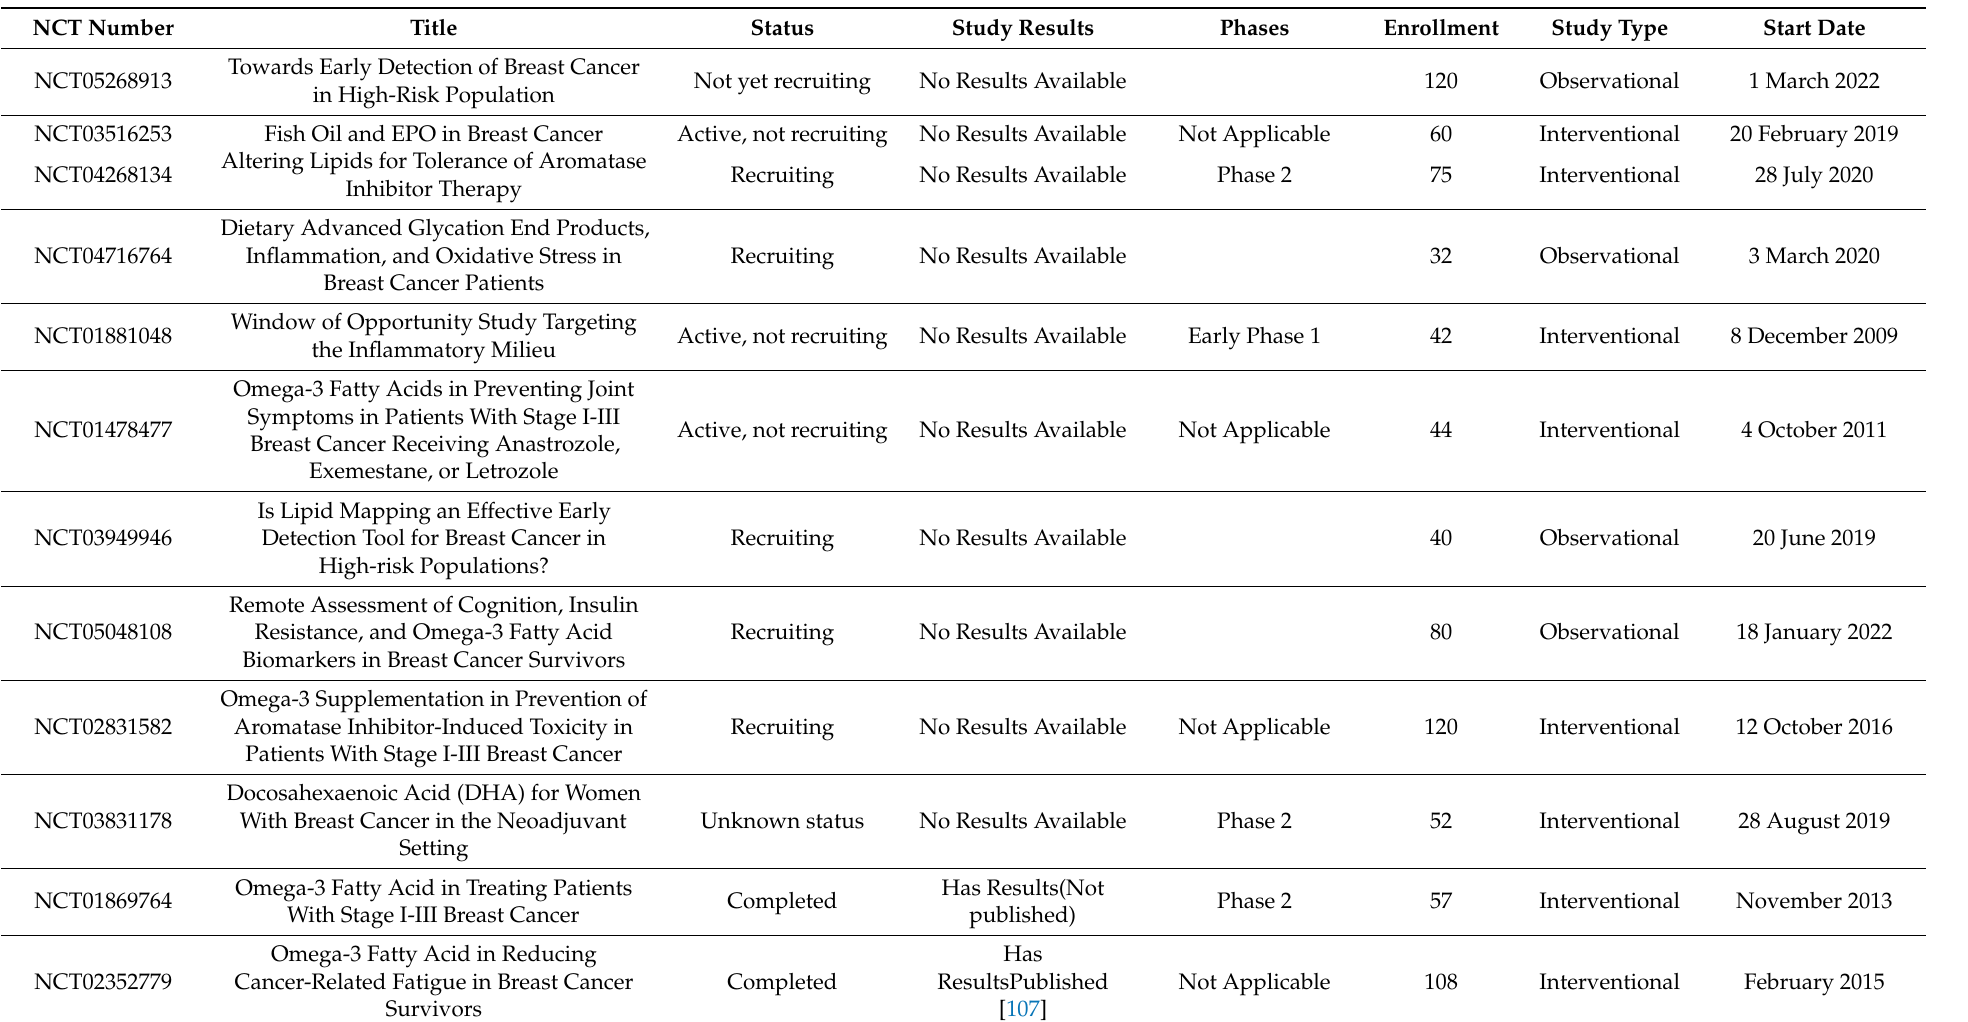
Table 1. List of clinical trials testing the effects of n-3 LC-PUFAS on breast cancer that are less than 6 years